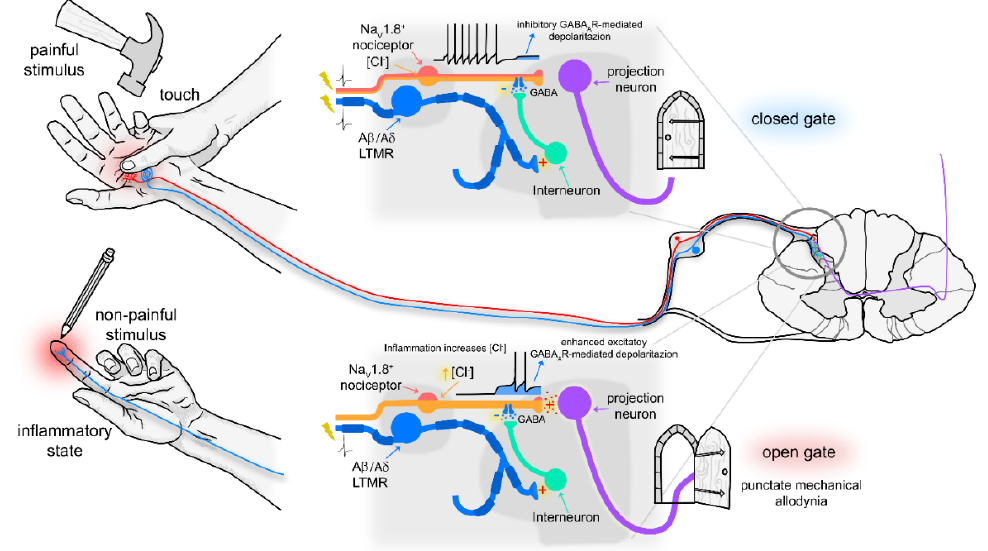
Figure 8. Schematic illustrating putative role of presynaptic GABA A -R in mediating punctate me- chanical allodynia. Immediately after injury, light touch activates Aß/Aδ afferents (blue) that can relay onto GABAergic interneurons (green) that, in turn, make presynaptic contact with NaV1.8+ nociceptive afferent terminals (red). In the upper panel, GABA acting via presynaptic GABA A -R results in modest depolarization of the nociceptive terminal (blue shading) that quells transmitter release, closing the gate to transmission from NaV1.8+ afferents to nociceptive projection neurons (purple). In response to persistent inflammatory injury, the intracellular chloride concentration in NaV1.8 + sensory neurons is elevated (orange shading). This allows GABA acting via presynaptic GABA A -R to elicit transmitter release from NaV1.8 + terminals, opening the gate for a circuit from Aß/Aδ afferents, through GABAergic interneurons that usurp the NaV1.8 + to activate nociceptive projection neurons.